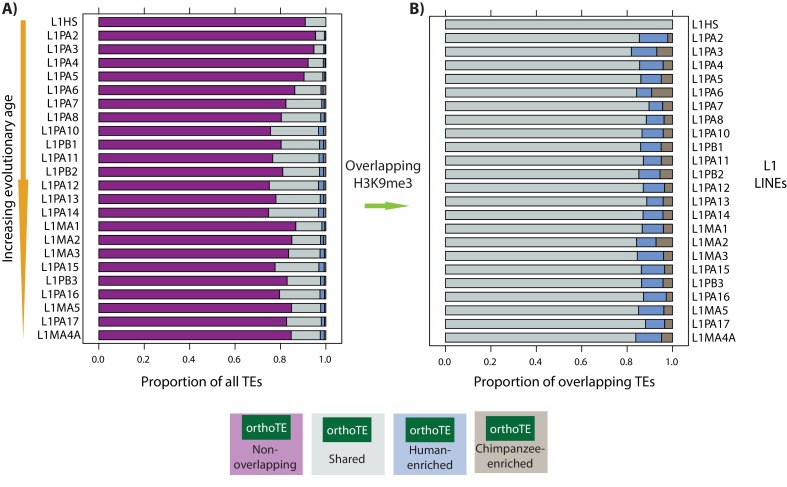
LINE-1 TE types are similarly enriched for H3K9me3 in humans and chimpanzees.(A) The proportion of a subset of L1 types that do not overlap an orthologous H3K9me3 region (magenta), show similar H3K9me3 enrichment in both species (grey: Shared), are enriched in human (blue: Human-enriched), or are enriched in chimpanzee (brown: Chimpanzee-enriched) are shown. Elements are ordered from youngest to oldest. (B) The proportion of L1 types that overlap an orthologous H3K9me3 region and is either Shared, Human-enriched or Chimpanzee-enriched. Curated list of L1 elements from Castro-Diaz et al.